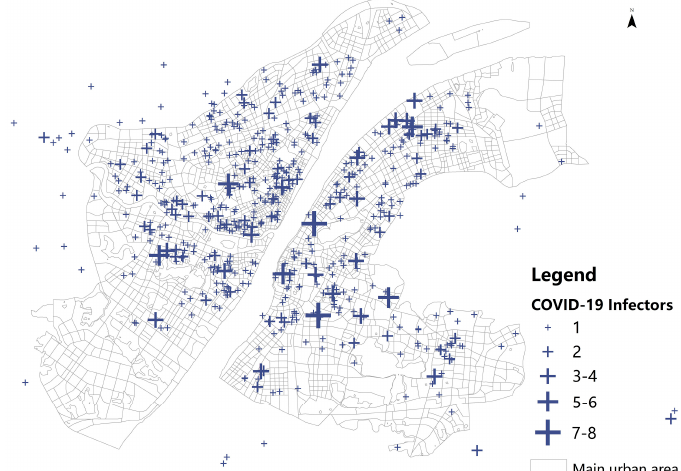
Figure 9. Spatial distribution of Weibo help seekers in the main urban area of Wuhan.